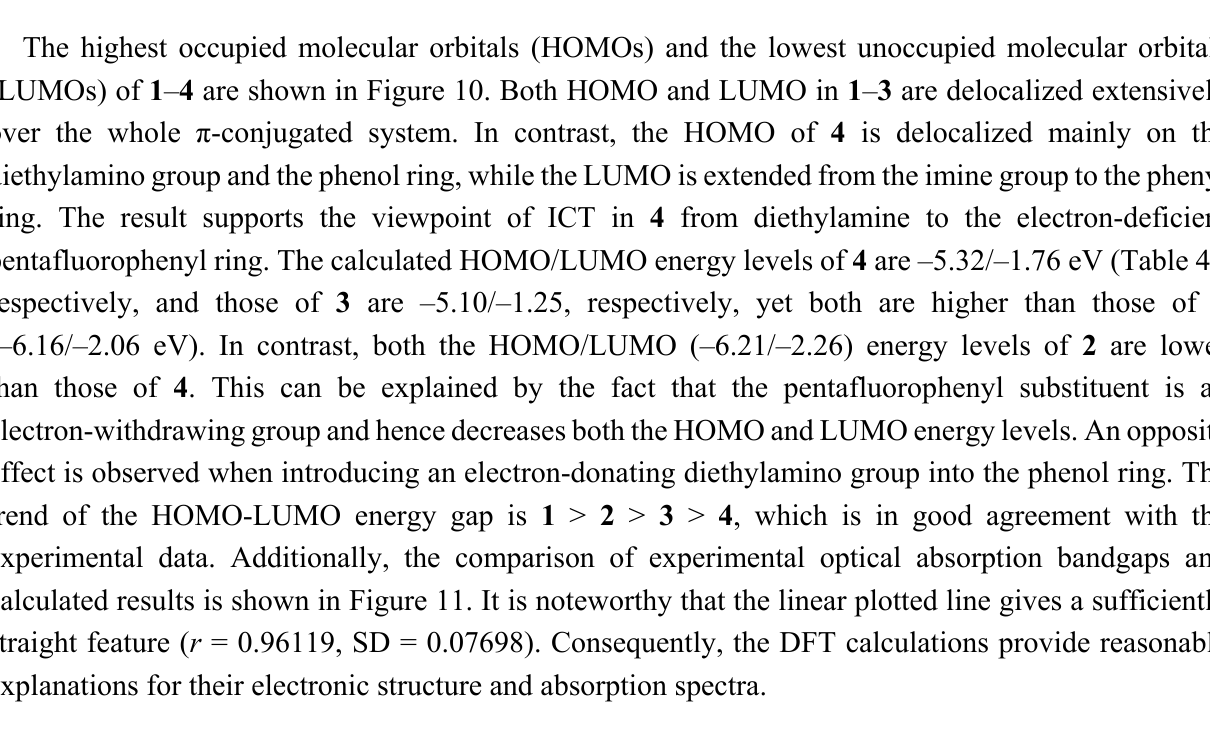
Figure 10. Calculated frontier orbitals for 1 – 4 . The upper graphs are the LUMOs and the lower ones are the